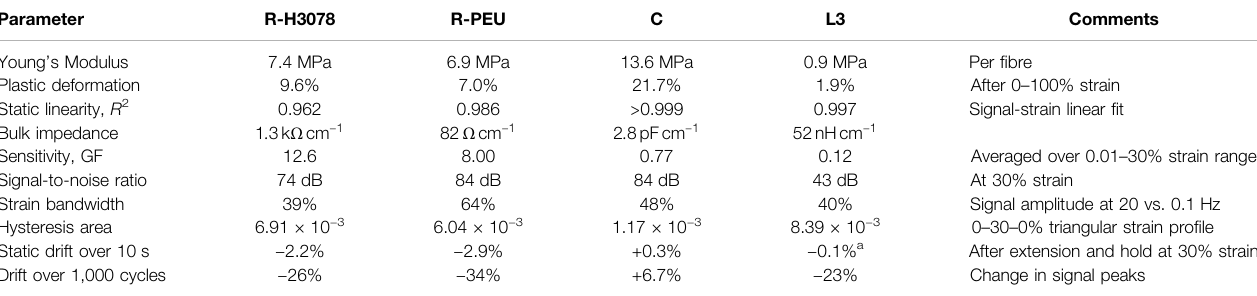
TABLE 2 | Summary table for the properties of each sensor studied with any test conditions noted in the comments column. Parameter